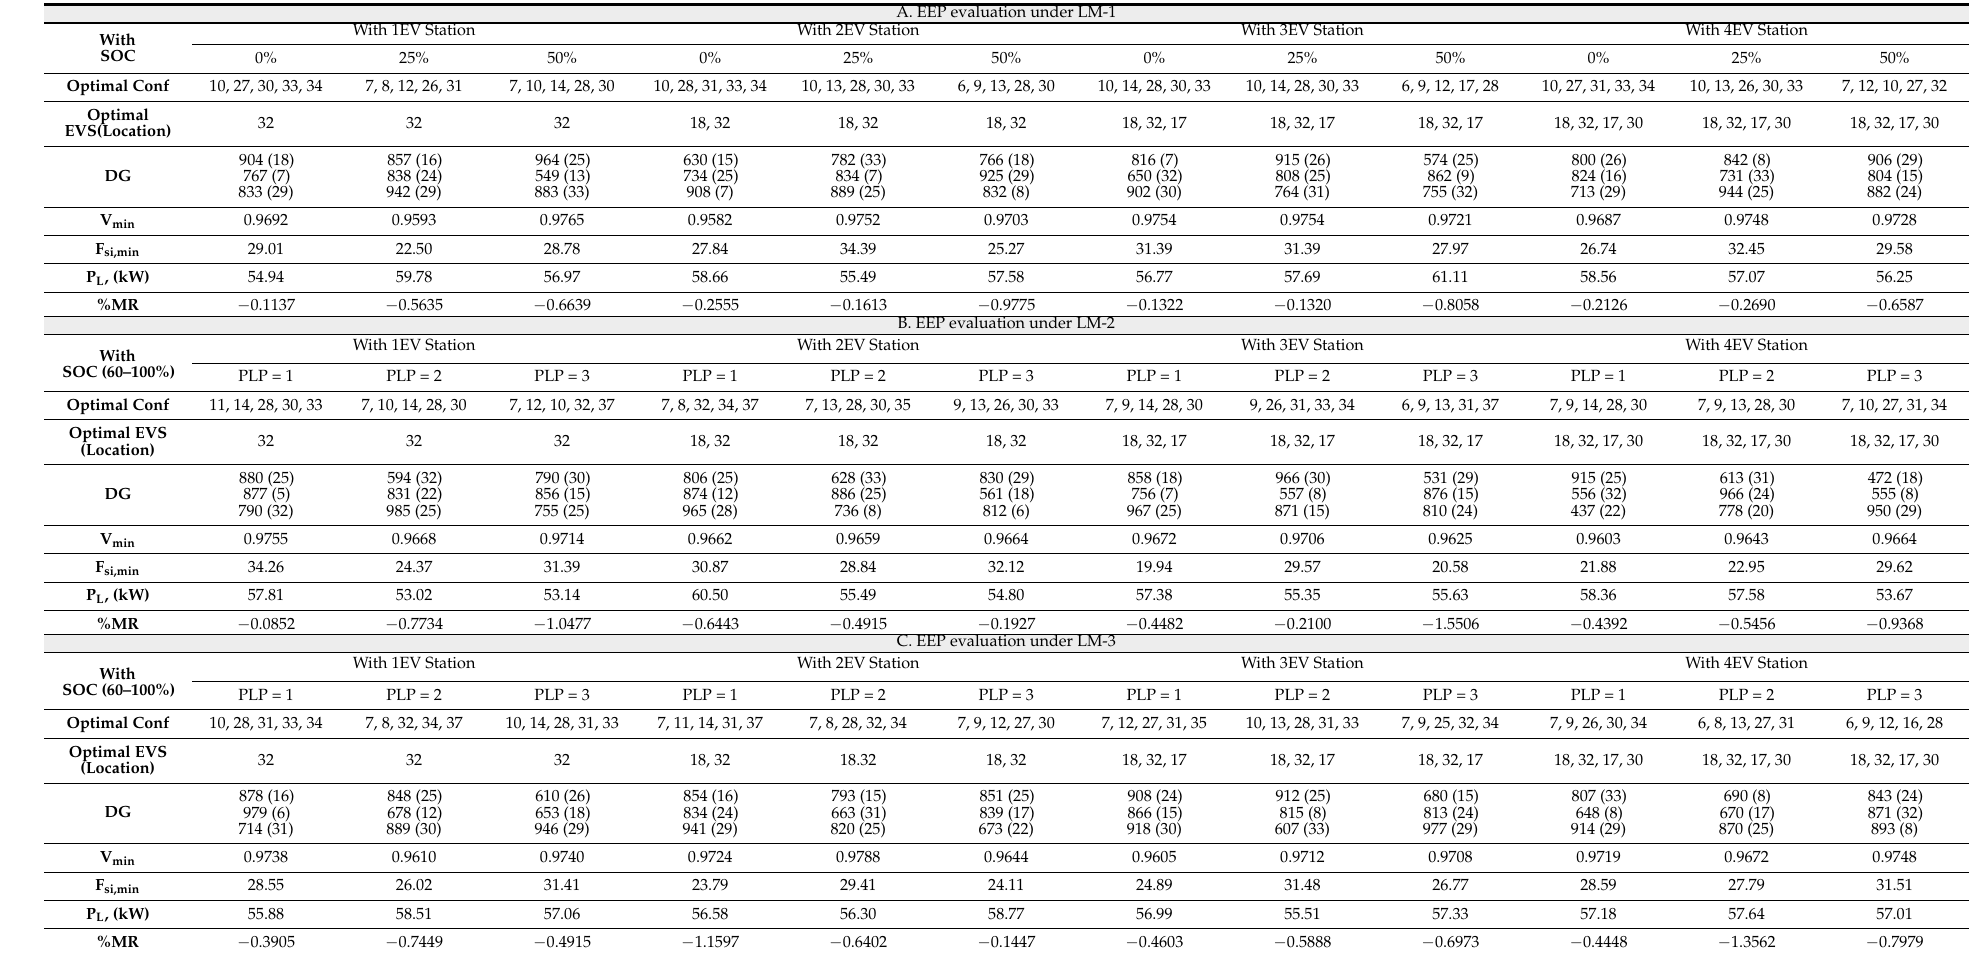
Table 10. EEP for Case-5 (ESS works as a